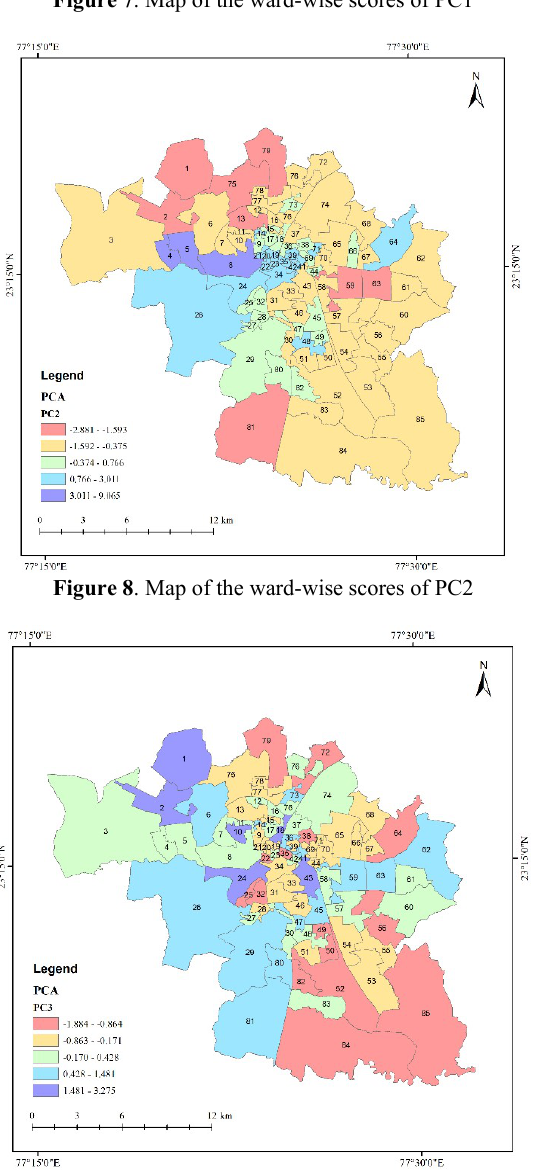
Figure 9. Map of the ward-wise scores of PC3